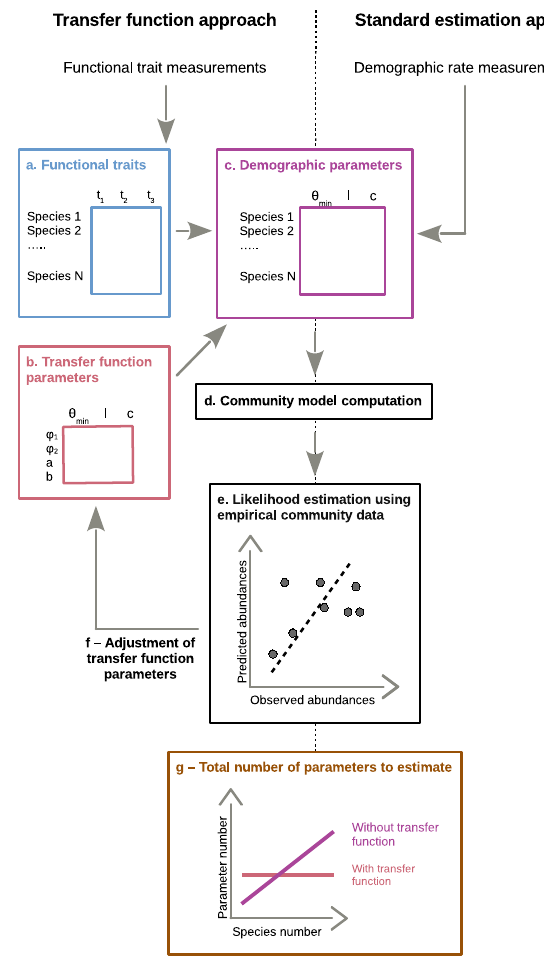
Fig. 1 Illustration the modeling procedure. From a data table ( a ) of three empirical functional traits data (t 1 , t 2 , t 3 ), we use a “ transfer function ” ( b ) controlled by a set of transfer function parameters { φ i,1 , φ i,2 , a i , b i }. Together they predict demographic parameter values across species ( c ). table. The likelihood of empirical community data given the parametrization is estimated using an appropriate likelihood function ( e ). The latter depends on the nature of the community model output and of the observed data (e.g. species abundances, species presence/absence, community diversity etc … ). The likelihood value sets the next iteration of the distribution sampler by adjusting the transfer function parameters ( f